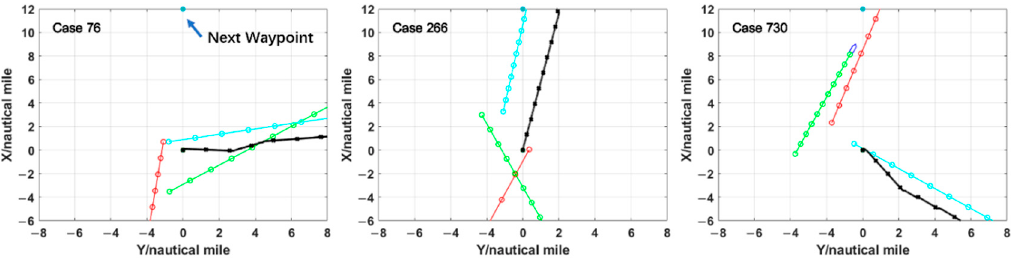
Figure 21. The failed examples on “parallel problem”.